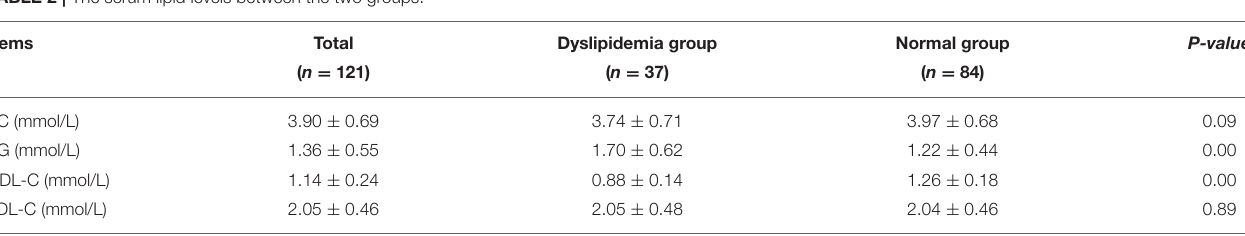
TABLE 2 | The serum lipid levels between the two